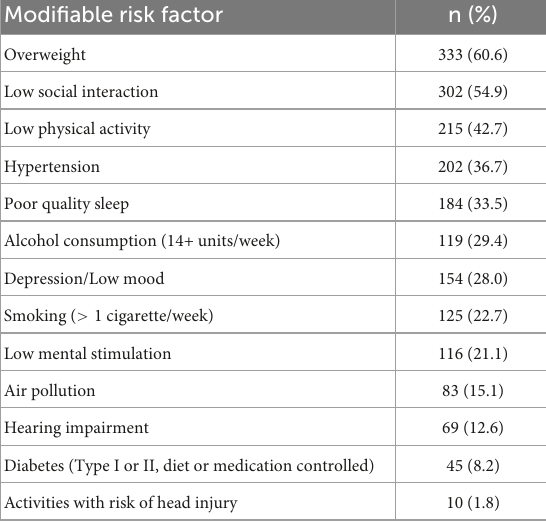
TABLE 2 Exposure to modifiable risk